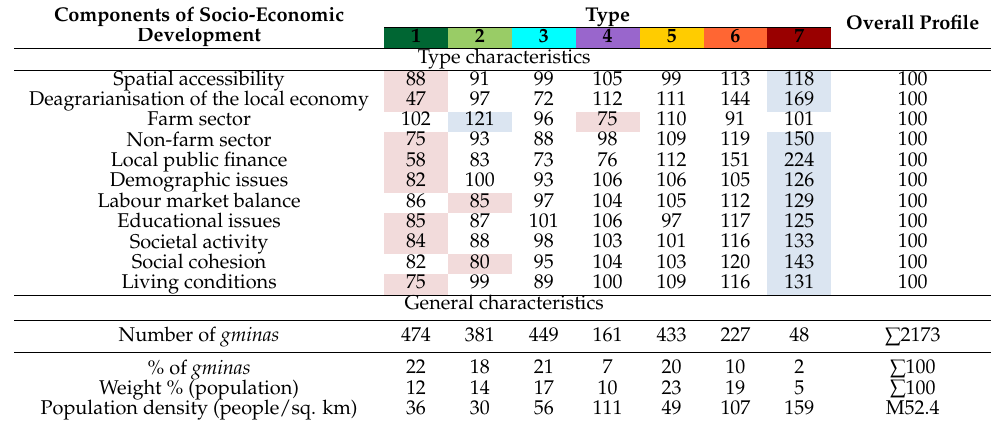
Table 1. Socio-economic characteristics of the types.